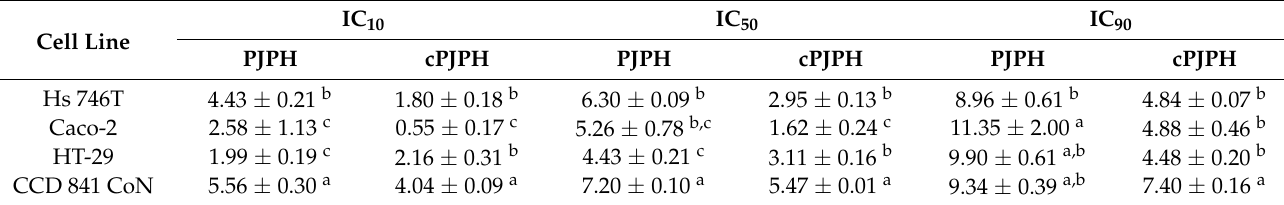
Table 5. Cytotoxic doses for stomach cancer cells (Hs746T line), colon cancer cells (HT-29 and Caco-2 lines), and colon normal cells (CCD 841 CoN line) [mg dm